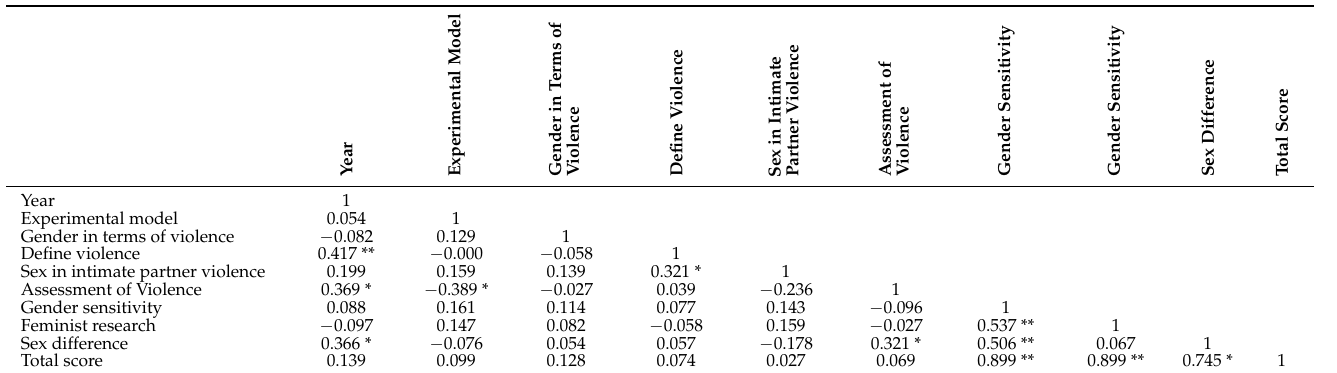
Table 4. Spearman’s correlation